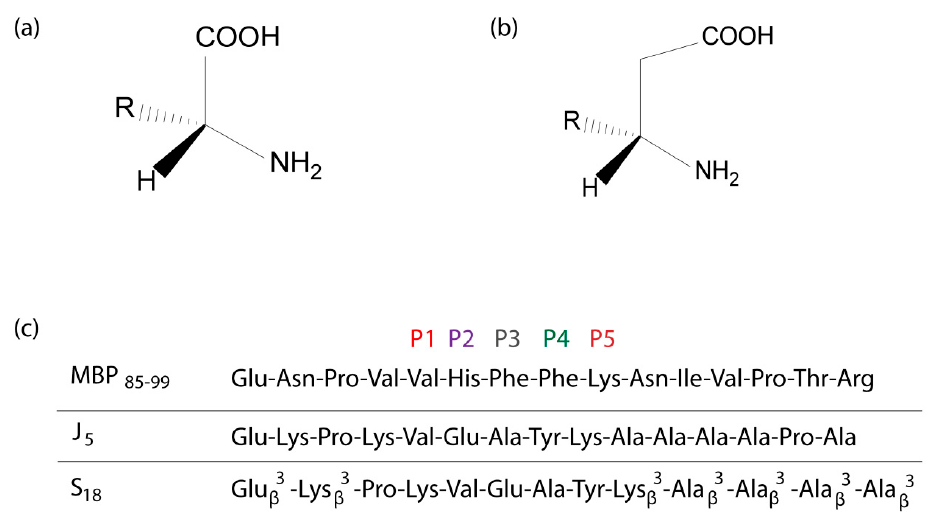
Figure 11. ( a ) α -amino acid, ( b ) Homo- β -amino acid, ( c ) MBP 85-99 , J5 and S 18 analogue.